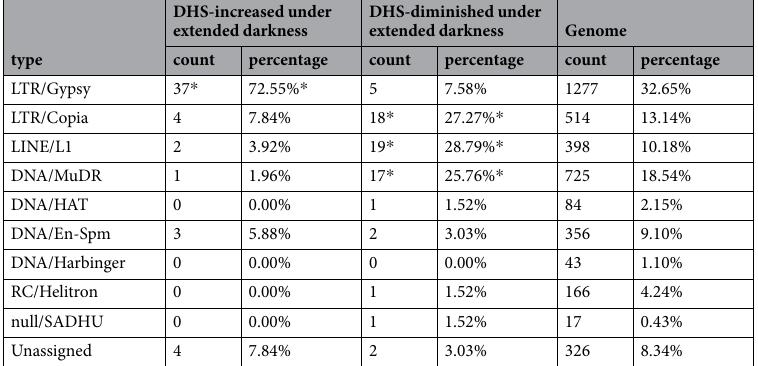
Table 2. Differential TE families in DHSs under extended darkness and control condition. * Indicates a significant difference. Significance was calculated by hypergeometric distribution with a cut-off of